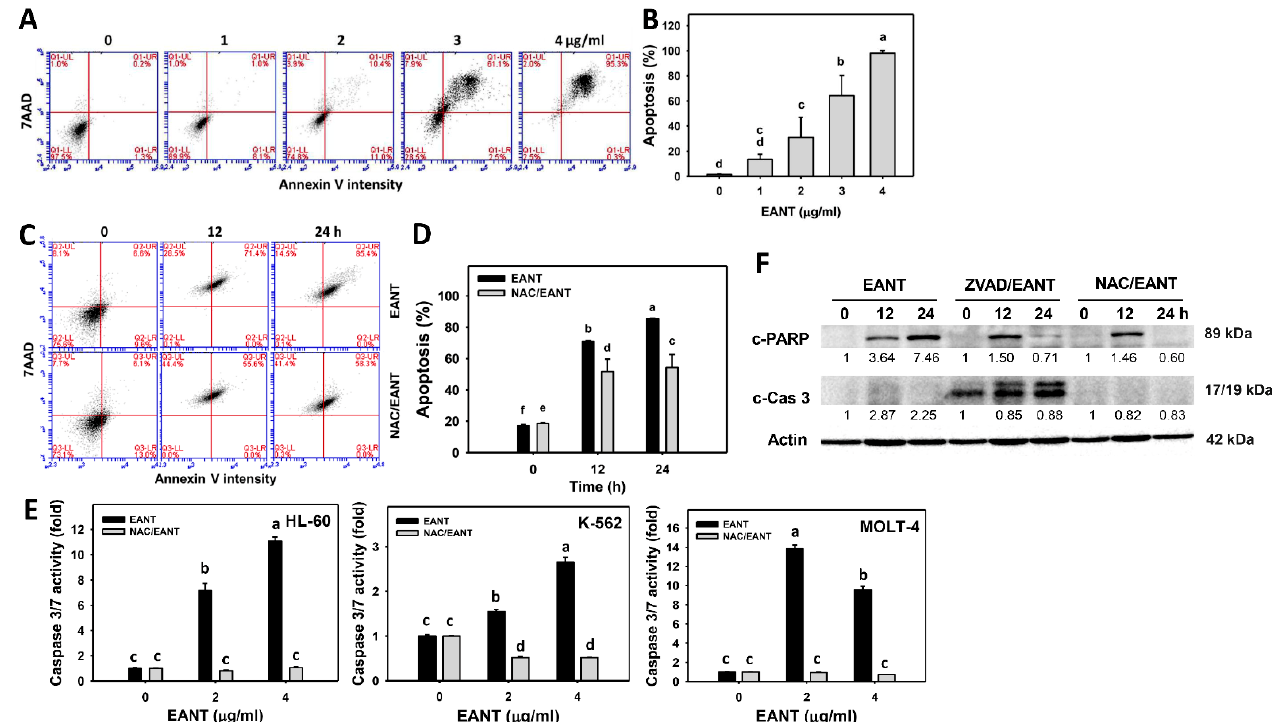
Figure 4. Annexin V status of EANT-treated leukemia cells. ( A , B ) Histogram and statistical analysis for annexin V expression. Apoptosis (%) was calculated to the populations of annexin V (+)/7AAD (+/ − ) (%). HL-60 cells were treated with EANT (24 h, 0 to 4 µ g/mL). The control contained 0 µ g/mL EANT but 0.1% DMSO. ( C , D ) Histogram and statistical analysis for annexin V detection of HL-60 cells following NAC/EANT treatment. NAC/EANT indicates that cells are either pretreated with NAC (5 mM, 1 h) or post-treated with EANT (0 and 4 µ g/mL for 0, 12, and 24 h). ( E ) Caspase 3/7 activity assay of HL-60, K-562, and MOLT-4 cells following NAC/EANT treatment for 1 h/24 h. Data, mean ± SD ( n = 3). Data showing different letters at the top revealed a significant difference ( p < 0.05–0.0001 for multiple comparisons). ( F ) Western blot analysis of c-PARP and c-Cas 3 expressions in HL-60 cells following NAC (5 mM, 1 h)/EANT or ZVAD (100 µ M, 2 h)/EANT treatments.